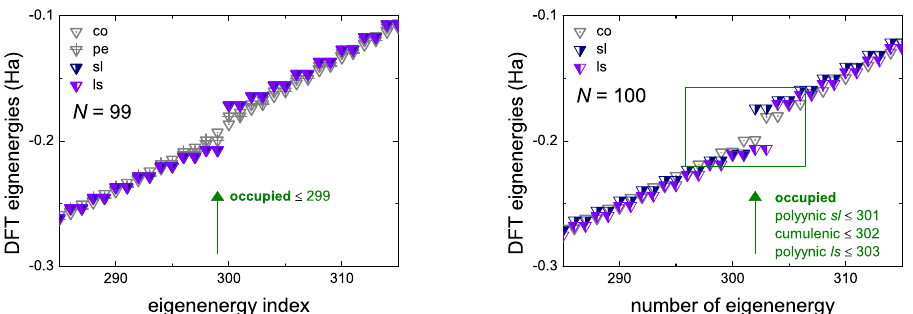
Figure 8. An example, for N = 99 and N = 100, of the formation of energy gap between occupied and empty eigenstates of neutral molecules, as obtained by our DFT simulations, at the B3LYP/cc-pVTZ level of